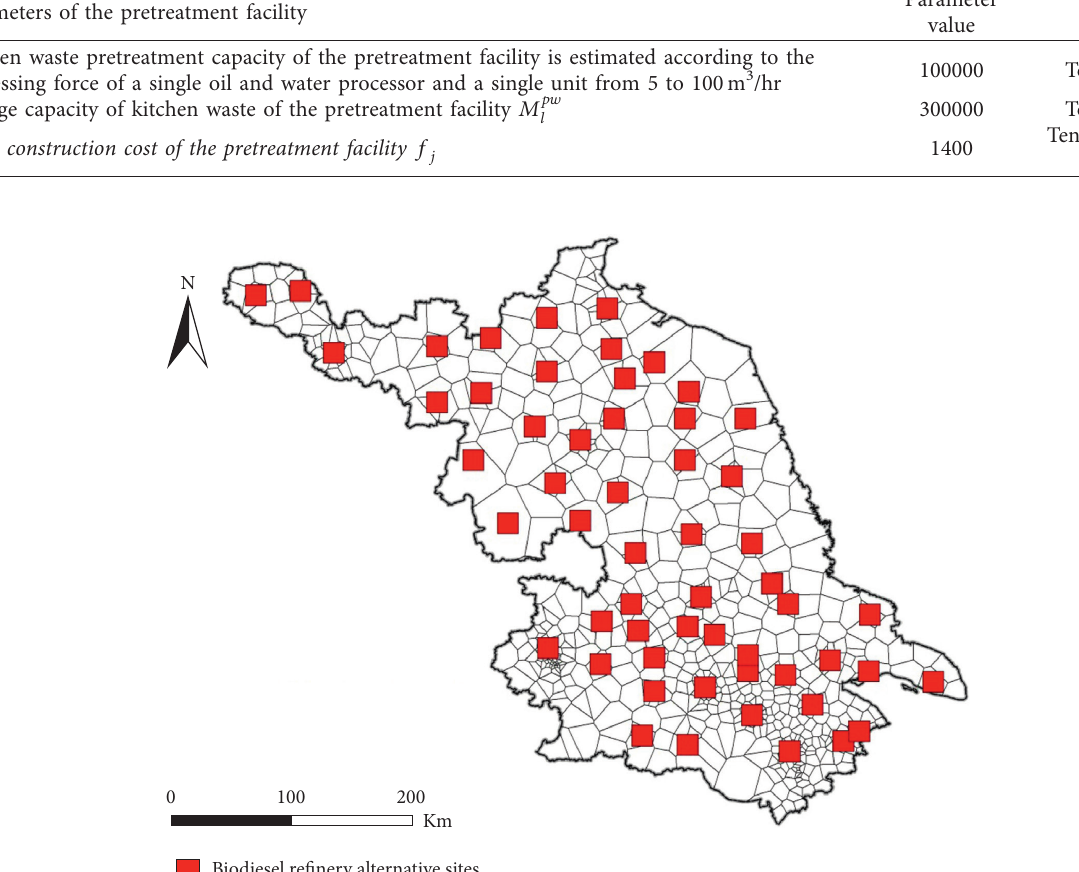
Figure 7: Alternative locations of biodiesel refineries in Jiangsu Province.